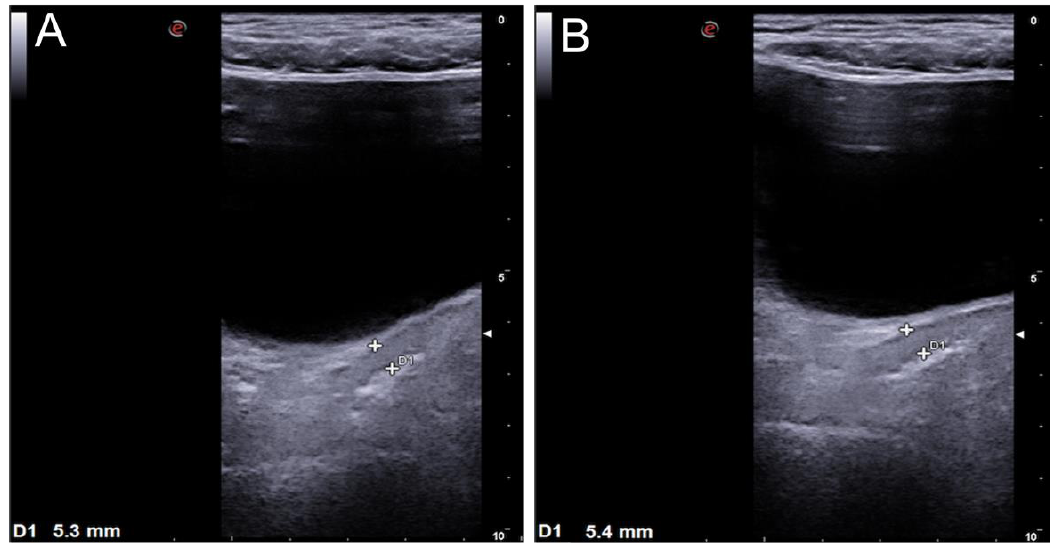
Figure 1. US findings in patient 3. ( A , B ) US findings at GvHD flare showing increased submucosa layer thickening at sigma colon level.